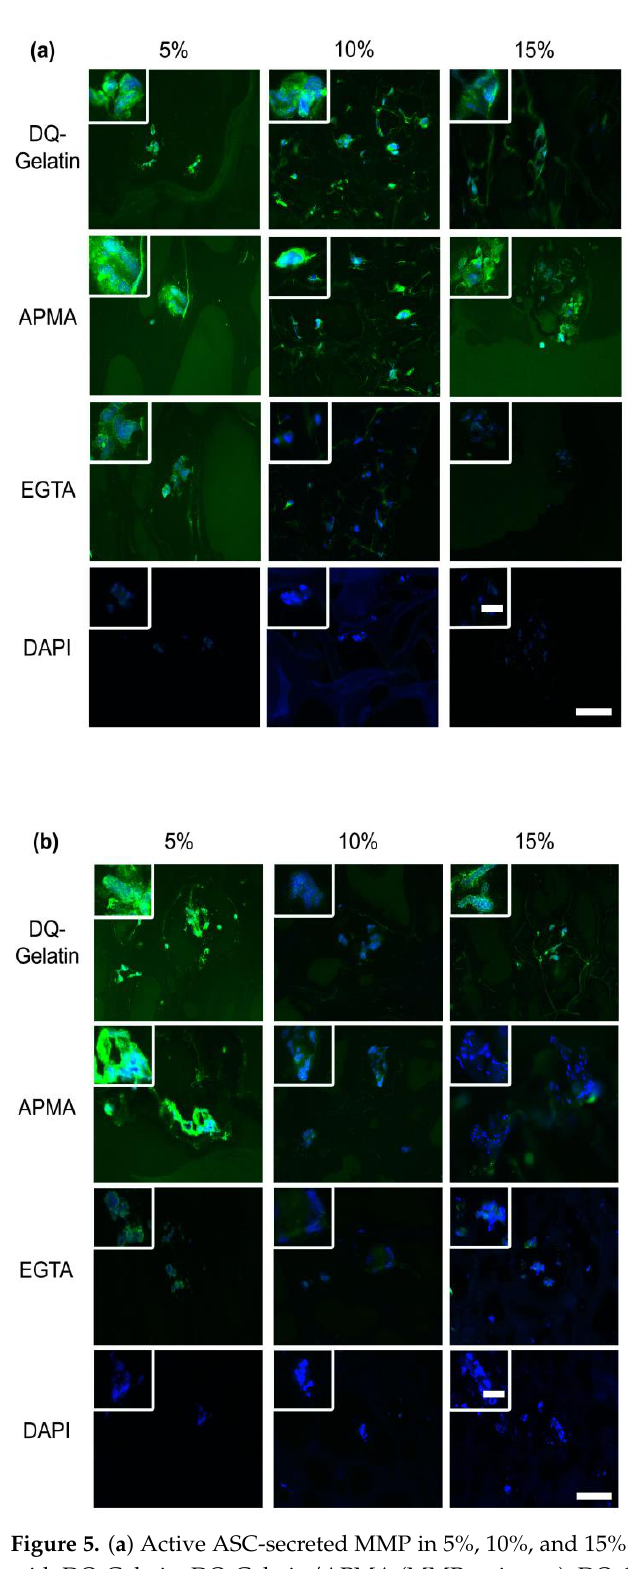
Figure 5. ( a ) Active ASC-secreted MMP in 5%, 10%, and 15% GelMA at 1 d. Cryosections stained with DQ-Gelatin, DQ-Gelatin/APMA (MMP activator), DQ-Gelatin/EGTA (MMP inhibitor), and DAPI only. Representative images are shown. Scale bars represent 10 µm (magnified view) and 50 µm (overview). ( b ) Active ASC-secreted MMP in 5%, 10%, and 15% GelMA at 14 d. Cryosections stained with DQ-Gelatin, DQ-Gelatin/APMA (MMP activator), DQ-Gelatin/EGTA (MMP inhibitor), and DAPI only. Representative images are shown. Scale bars represent 10 µ m (magnified view) and 50 µ m